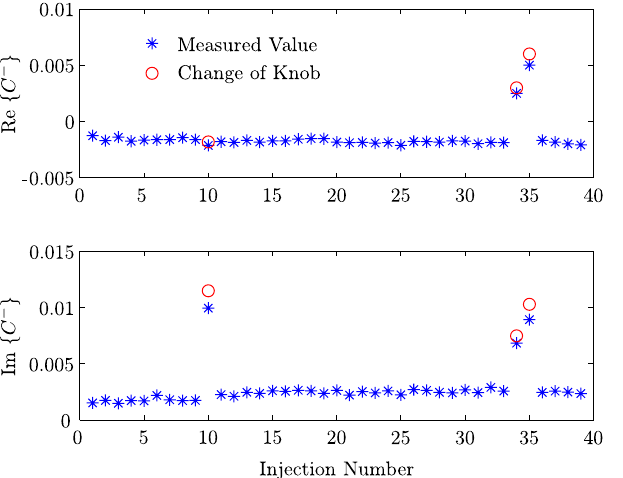
FIG. 7. The C − after a technical stop. The green circle shows the setting of the correction knobs while the blue stars show the measured C − . At A and B the coupling was adjusted manually, observing an increase in the coupling and at point C the automatic correction was used, which successful decreased the